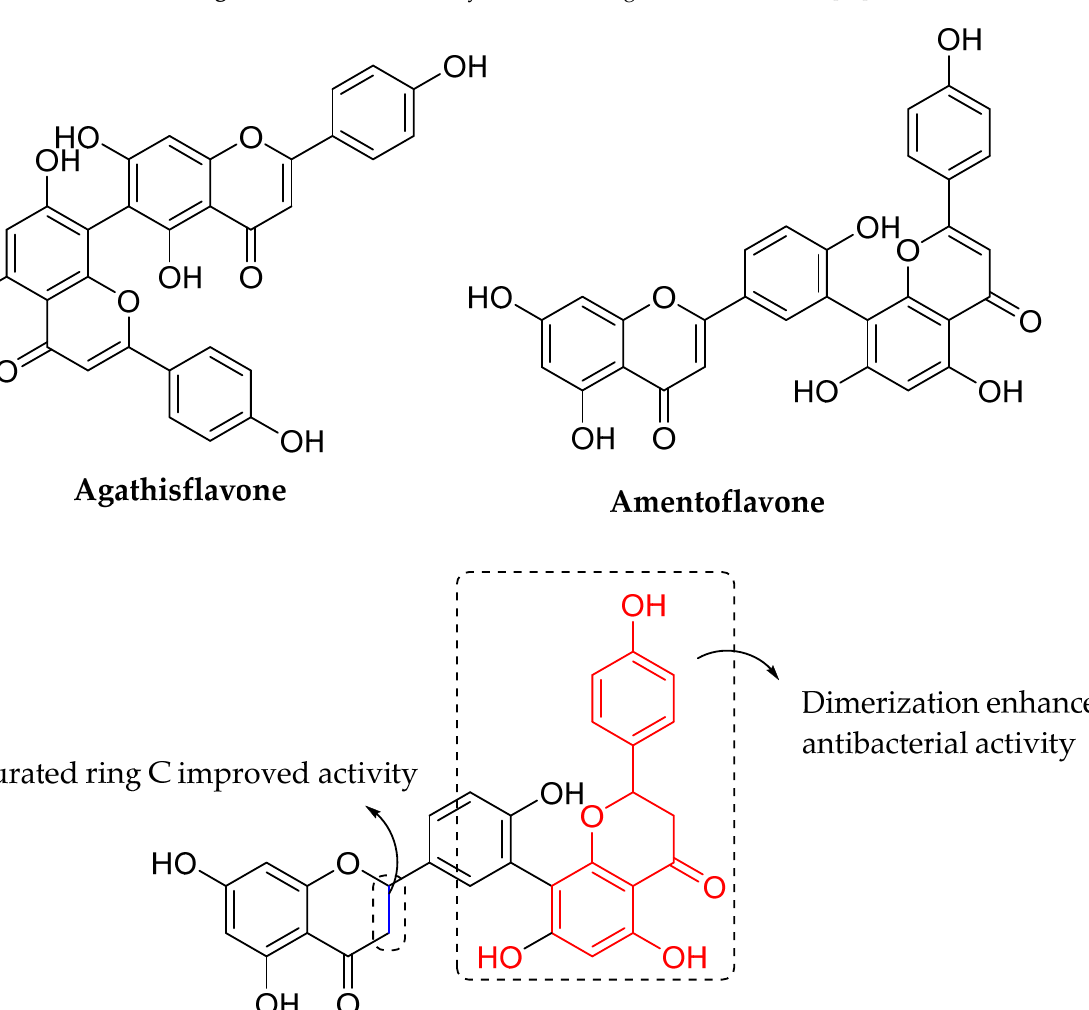
Figure 19. The chemical structures of biflavonoids isolated from Schinus terebinthifolius Raddi fruits [85].